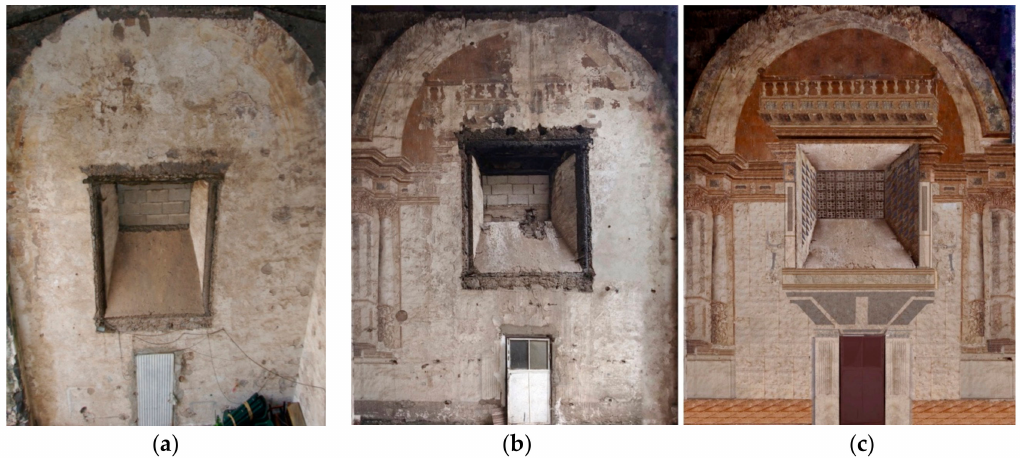
Figure 12. ( a ) Left facing of the presbytery (LW), ( b ) Right facing of the presbytery (RW), ( c ) virtual restoration of RW using DStretch ® and Photoshop drawing